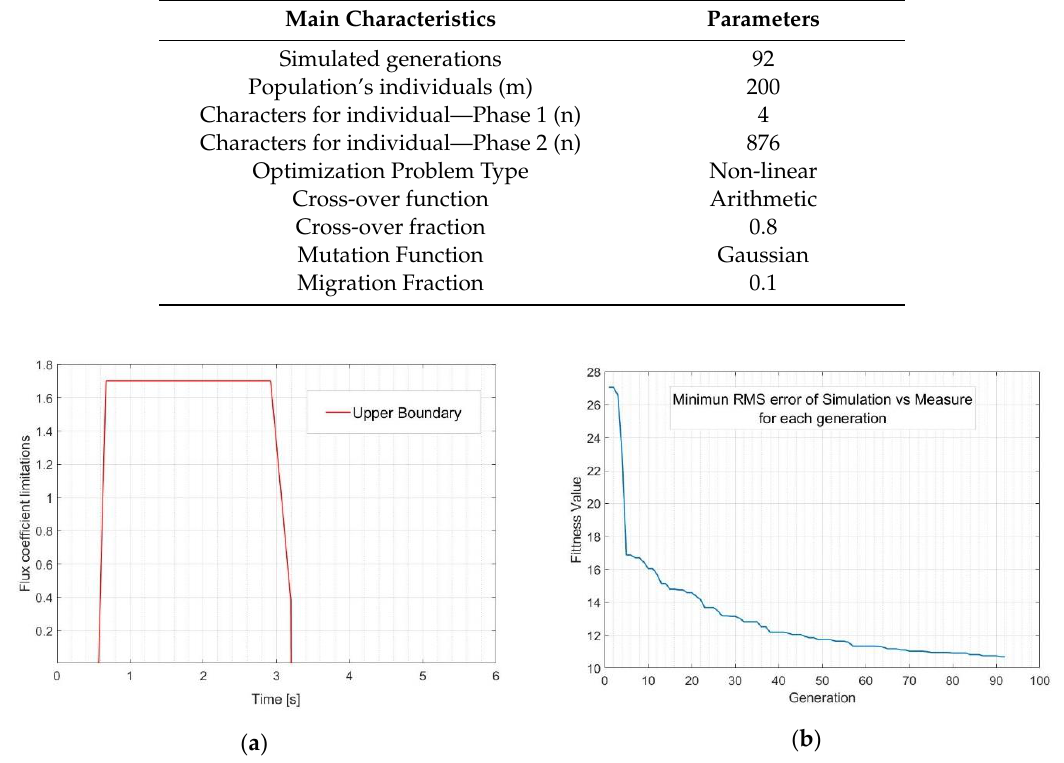
Table 1. Main characteristics and parameters assumed for the genetic algorithm used.